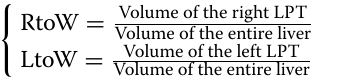
RtoW = Volume of the right LPT Volume of the entire liver LtoW = Volume of the left LPT Volume of the entire liver